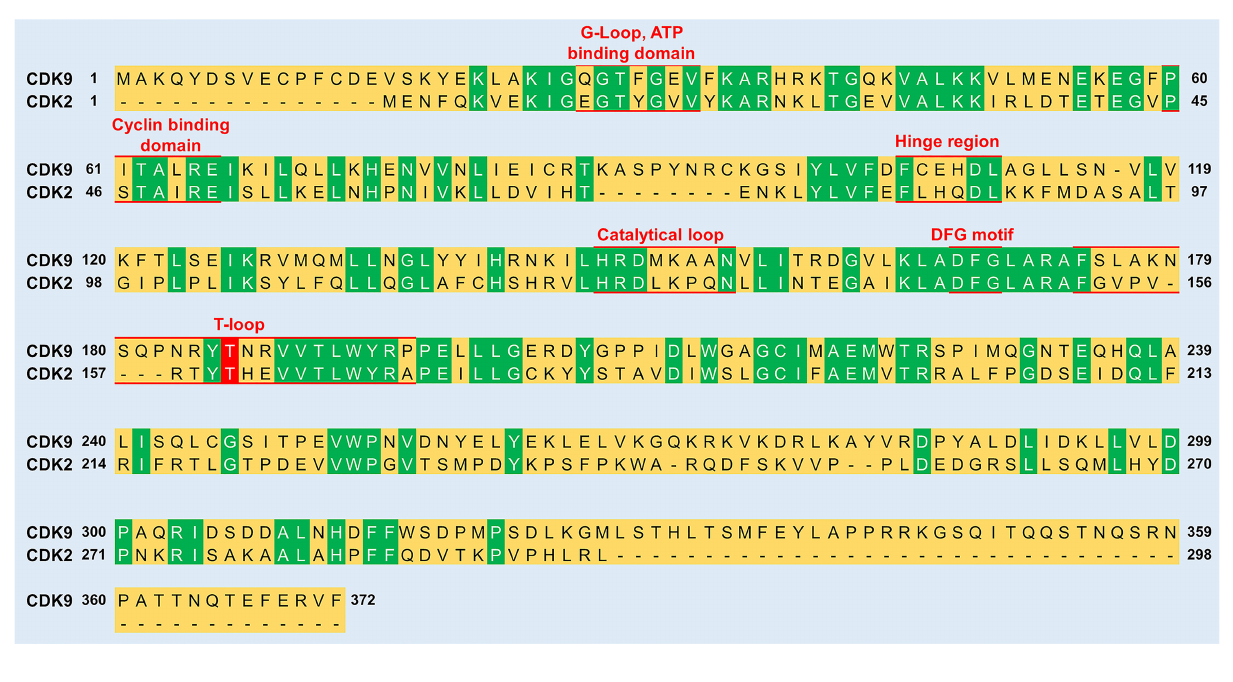
FIGURE 3 | Sequence comparison between CDK9 and CDK2. The sequence identity between the two proteins is 31.9%. Green color indicates residues conserved between CDK9 and CDK2. Red underlined residues indicate the different functional subunits of the kinases. In the T-loop, the phosphorylation of a conserved threonine residue (labelled red) is vital for the activation of both CDK9 (Thr186) and CDK2 (Thr160). The sequence alignment was generated and % sequence similarity determined using UniProt (https://www.uniprot.org/align/) and sequence identi fi ers were P50750 for CDK9 and P24941 for CDK2.